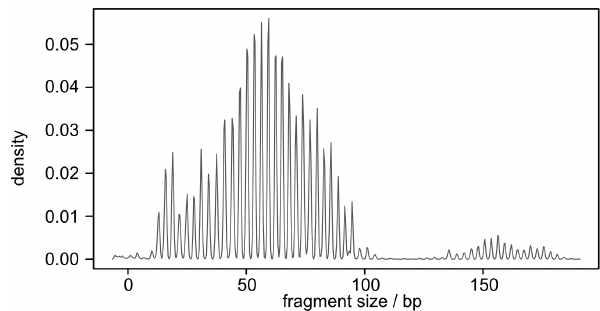
Figure 2. Bovine fetal IGH spectratype. Pooled data from 24 samples (four fetuses, six tissues/fetus: thymus, spleen, ileum, lymph node, liver, and bone marrow). Fragment size corresponds to the length of